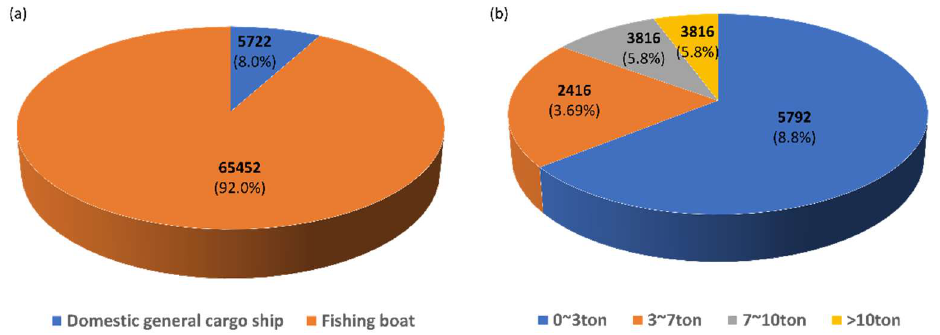
Figure 1. Methodology.